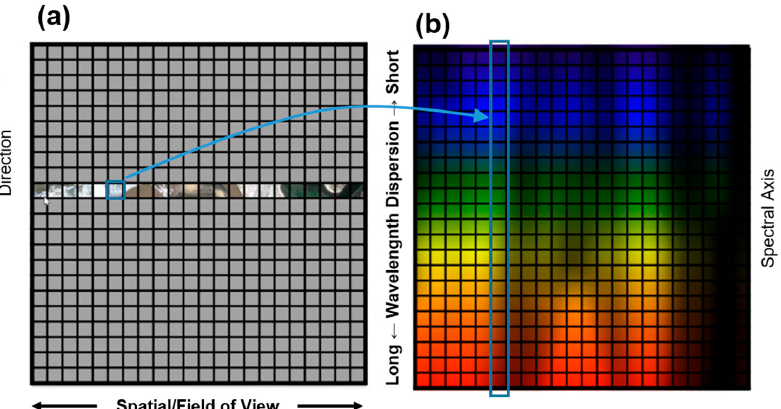
Figure 5. Operation principle (viewed through the slit): ( a ) spatial information collected, corresponding to the area scanned by the sensor—light passing the slit; ( b ) light passing the slit is dispersed on 272 bands, from the short to the long wavelength. Adapted from Headwall Photonics, Inc. Table 2. Nano-Hyperspec sensor specifications.